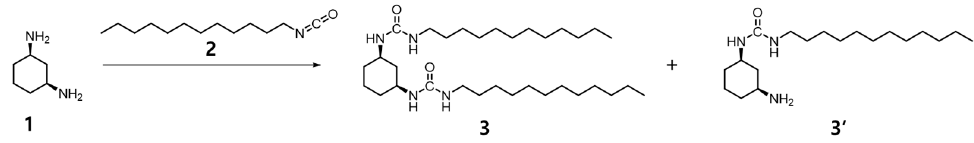
Figure 1. Reaction process to form in situ supramolecular gel by mixed compounds 1 and 2 .